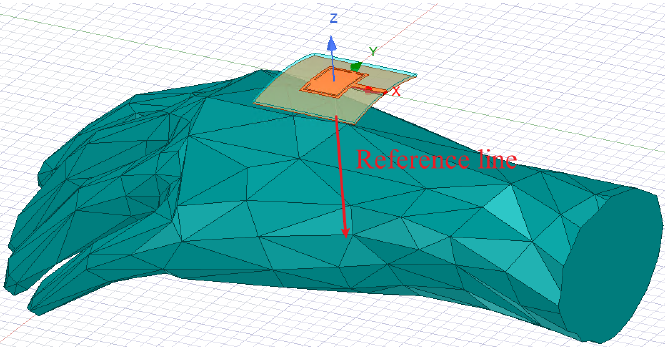
Figure 20. Human hand model and the reference line for SAR